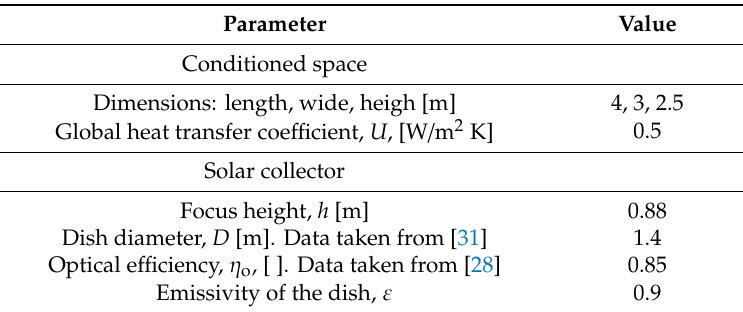
Table 1. Conditioned space and solar collector